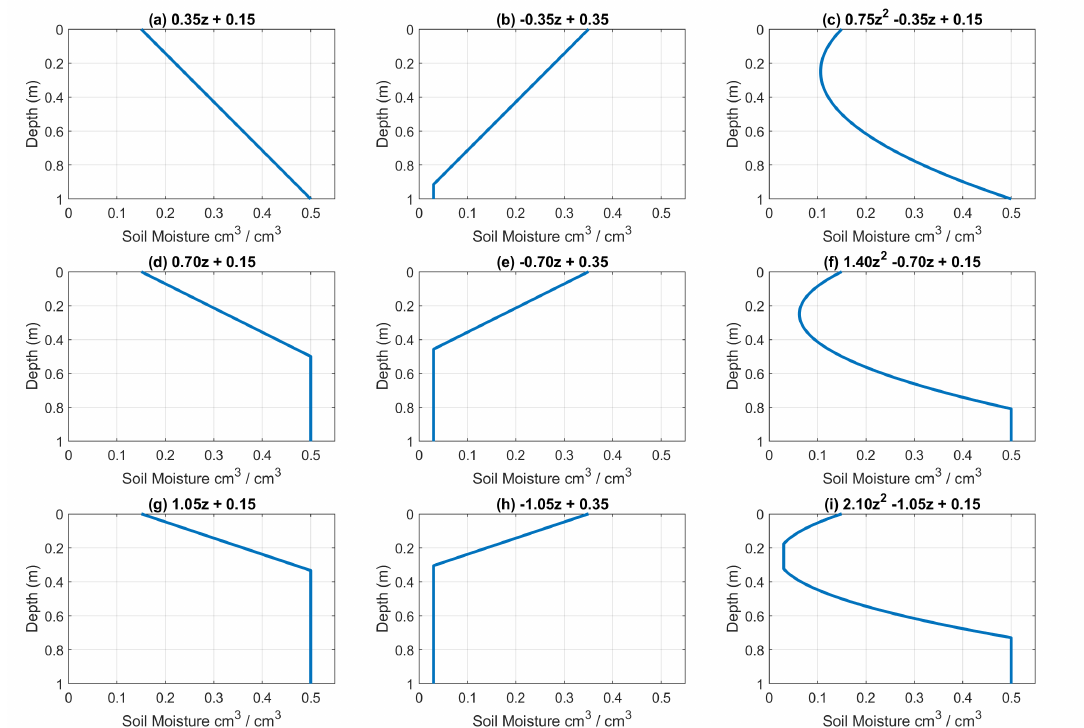
Figure 9. Example soil moisture profiles represented by polynomial-based equations indicated by the title of each subplot: ( a , d , g ) positive, linear soil moisture profiles; ( b , e , h ) negative, linear soil moisture profiles; and ( c , f , i ) second-order polynomial